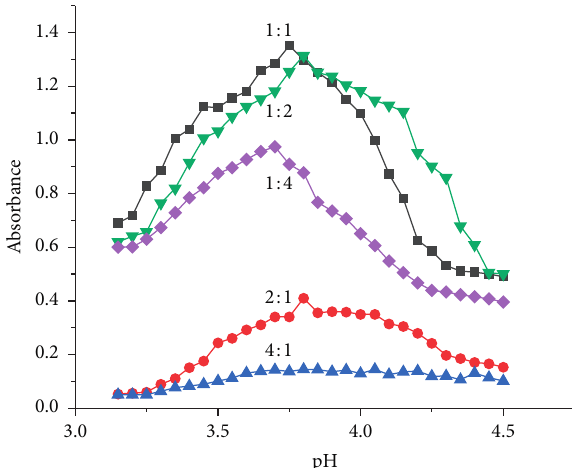
different pH and HKG:gelatin